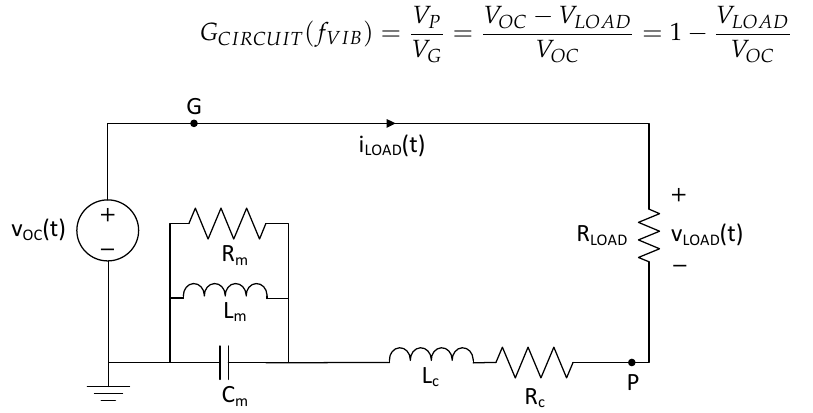
Figure 8. Alternative Thevenin form of the equivalent circuit of a single coil resonant electromagnetic vibration energy harvester.